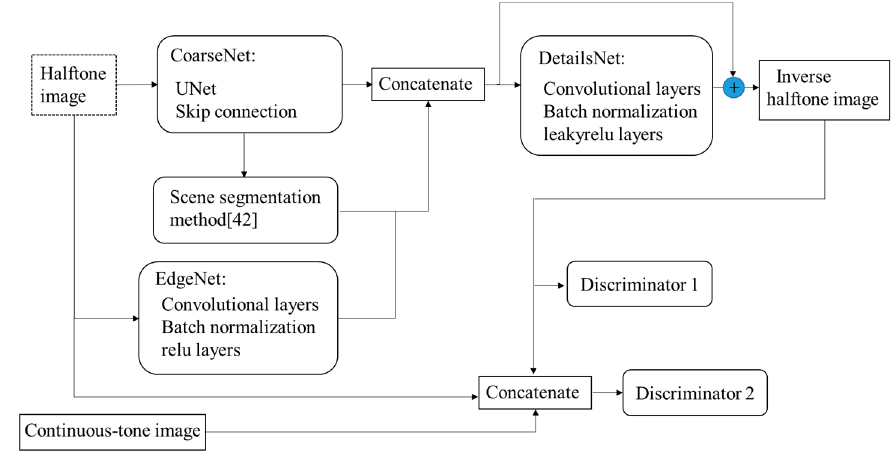
Figure 15. The network architecture proposed in reference [30].